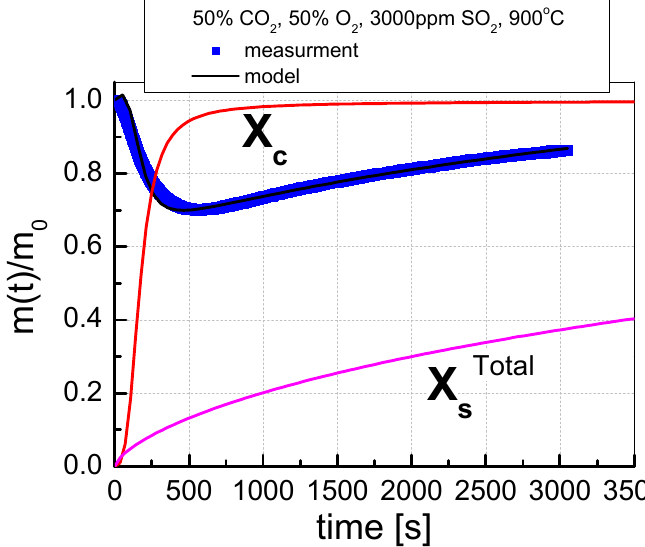
Figure 3. An example of the mass change process during the SCS test, indicating the results of the